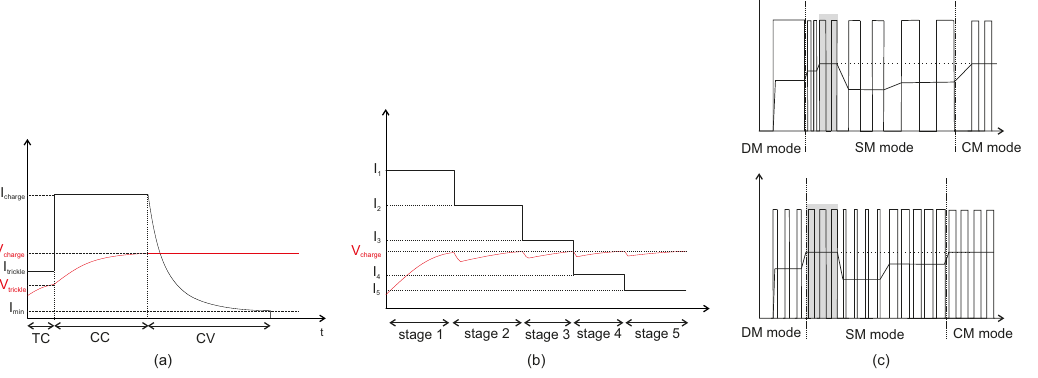
Figure 3. Charging methods: ( a ) CC/CV charging method; ( b ) multistage charging method; and ( c ) pulse charging method (above variable frequency pulse charge and below variable duty pulse current).